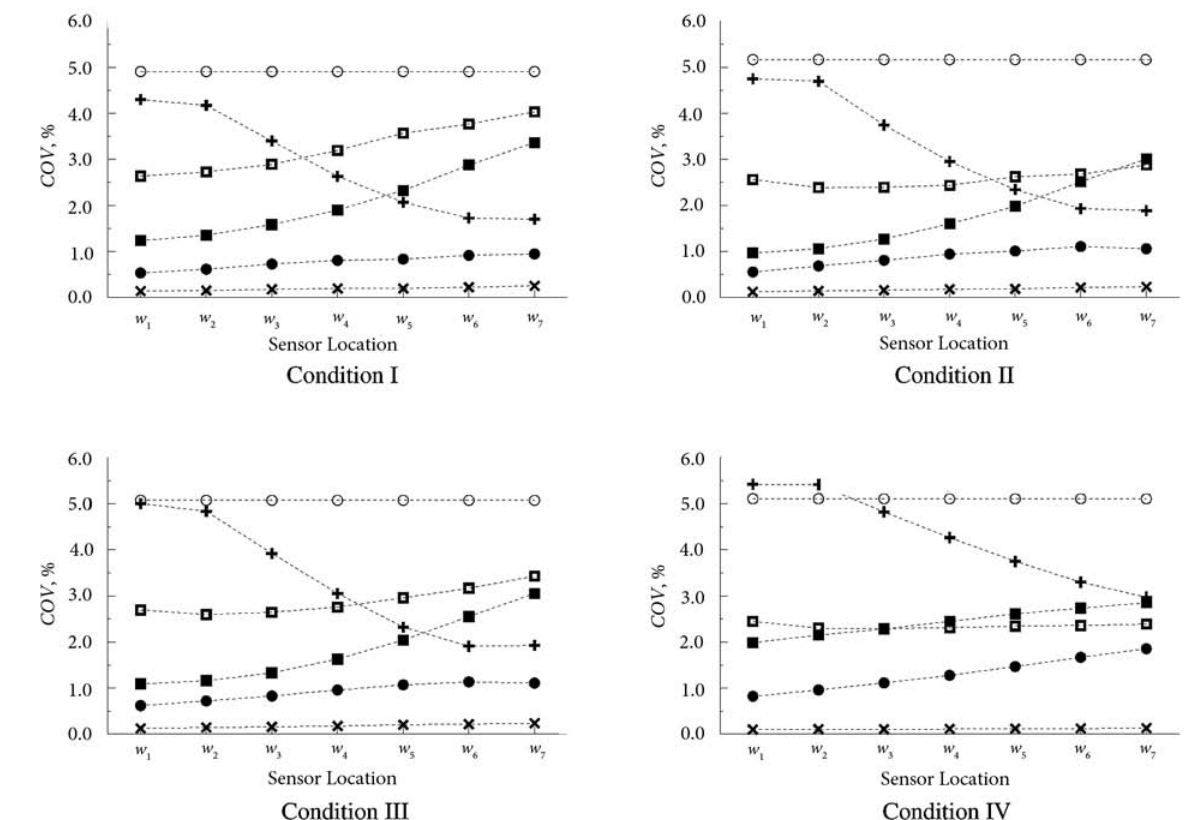
Fig. 4. COV ’s of max deflection data according to material uncertainties for bedrock boundary